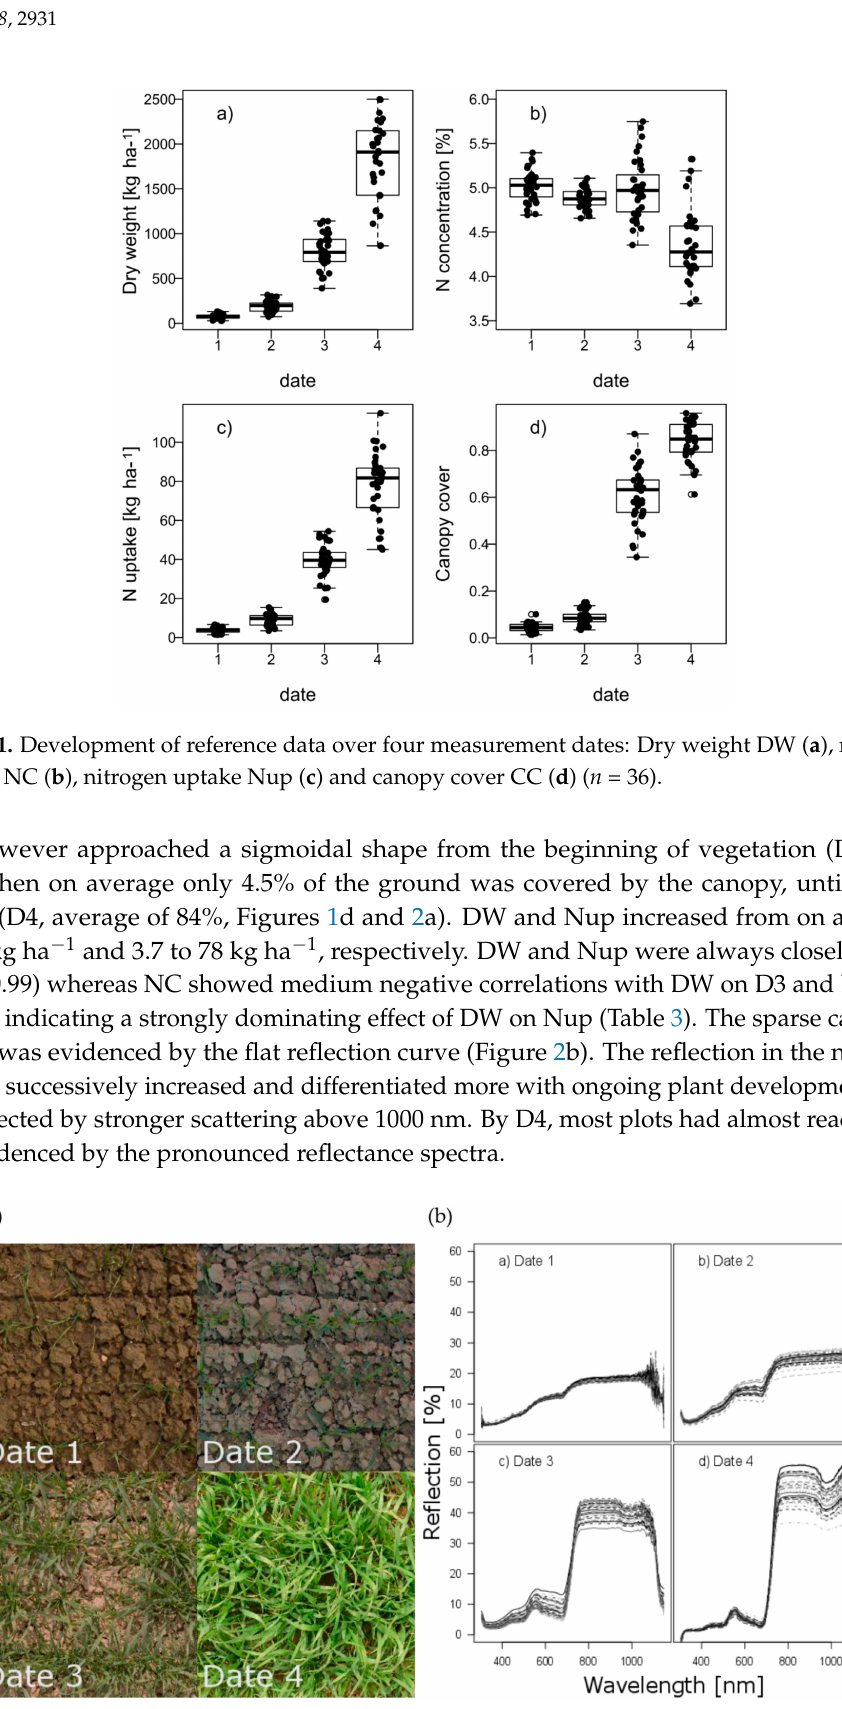
Figure 2. ( a ) Example of canopy development of a selected plot with cv. Hybery at N-level 2. ( b ) Development of spectral reflection of all experimental plots for four measurement